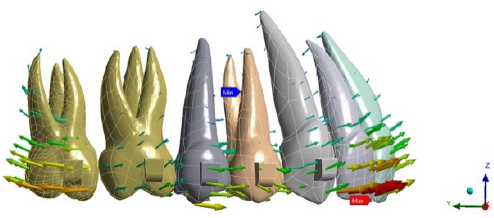
Figure 3. ATT 3–7 tooth displacement.